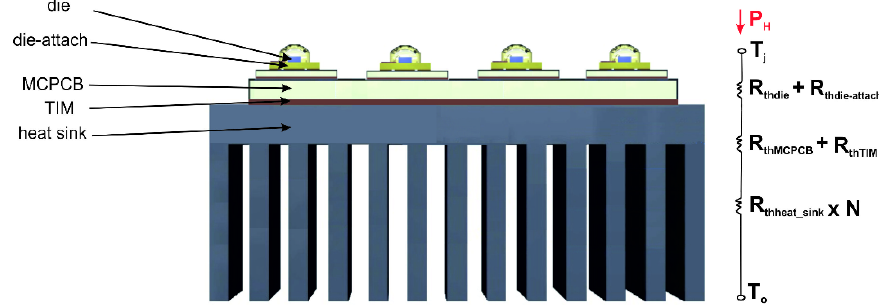
Figure 5. The components of a thermal circuit with many semiconductor light